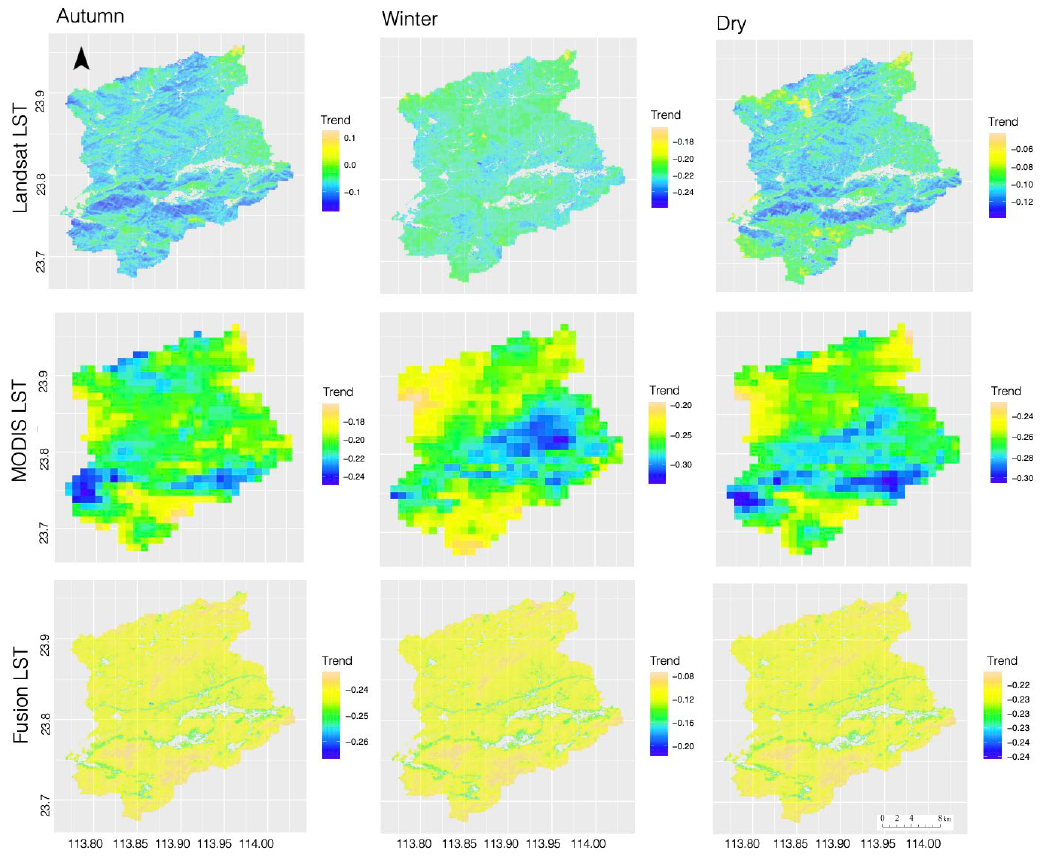
Figure 6. The dynamics of the land surface temperature ( LST ) in the subtropical forest derived from multisource remote sensing images in autumn, winter, and dry seasons. The three panels in the first row are derived from Landsat 8 LST images; the three panels in the second row are derived from MODIS LST images; the three panels in the third row are derived from Landsat- MODIS Fusion LST .